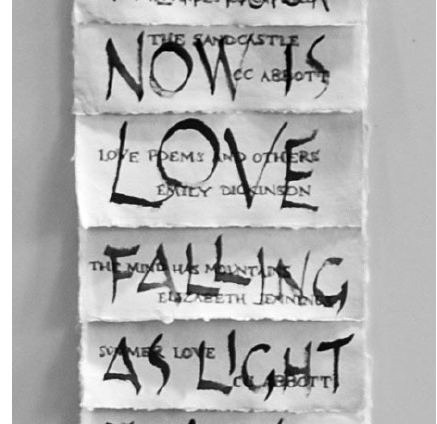
Figure 5 Dedication , artist’s book by Liz Mathews (detail). Photograph © 2020 Liz